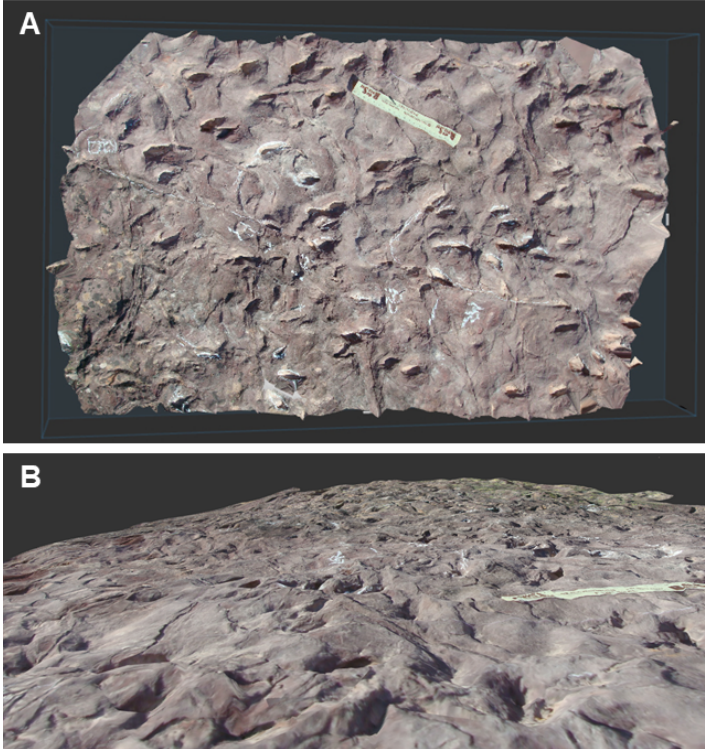
Figure 5. Photogrammetric three-dimensional modelling of the crocodyliform track CTA-2. ( A ) Top view of the crocodyliform track. ( B ) Detailed view of the negative relief of the crocodyliform track.